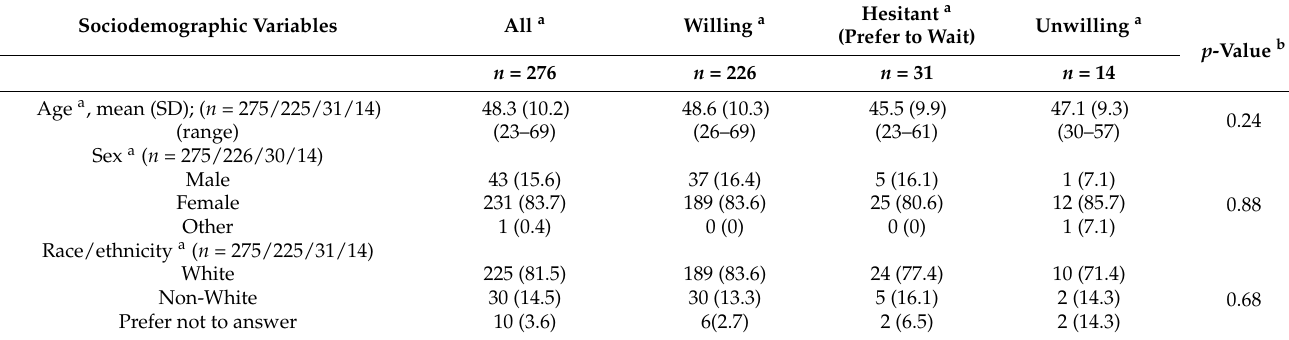
Table 1. Participant Characteristics ( n =